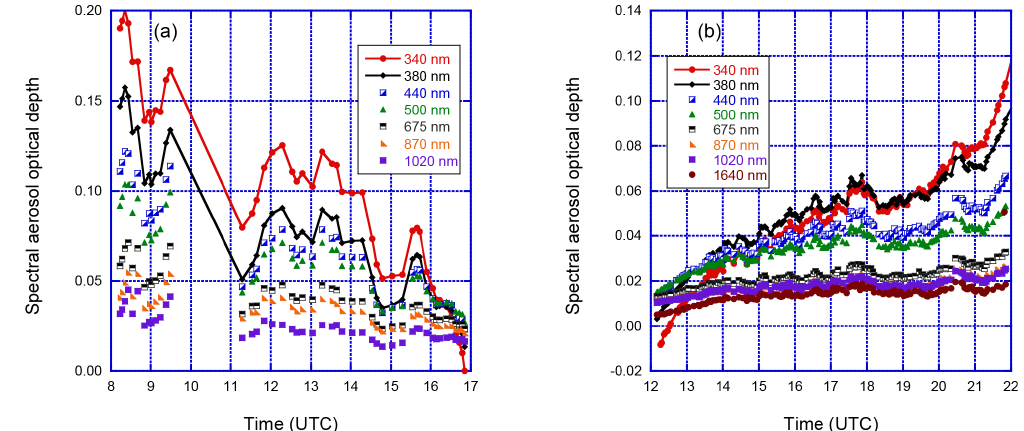
Figure 9. Time-shifted aerosol optical depth (AOD) data examples at Málaga (lat 36.72, long − 4.48) and Toronto (lat 43.79, long − 79.47). Note the line plot is used to emphasize the 340 and 380nm AOD impact for the time shift. (a) The Level 1.5 AOD cloud-screened-only data measured at the Málaga site on 30 January 2014. These data show the time-shifted AOD particularly at short wavelengths, representing that the instrument clock is too fast. (b) The Level 1.5 AOD cloud-screened-only data measured at the Toronto site on 24 September 2013. The time-shifted aerosol optical depth particularly at short wavelengths represents when the instrument clock was too slow. (a) Also shows the algorithm can be used with data gaps and a lower-temporal-resolution measurement interval compared to (b)